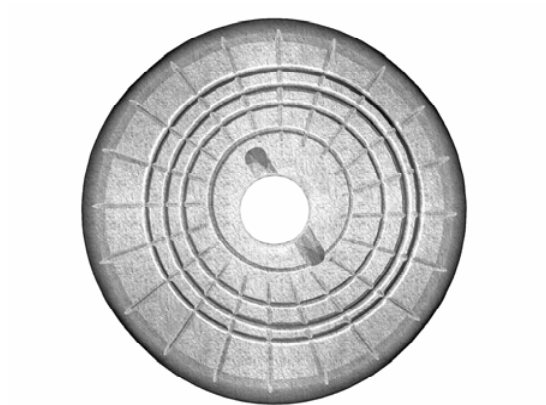
Figure 14. Proposal for reconstruction